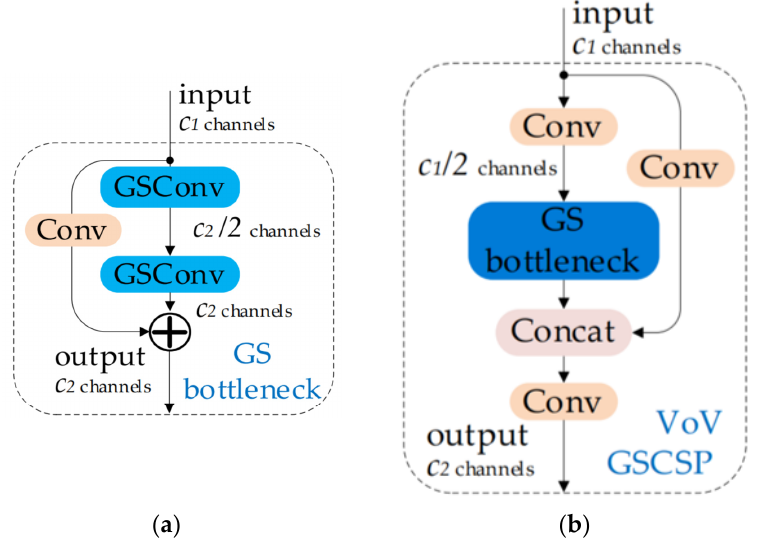
Figure 6. The structure of the GS bottleneck and VOV-GSCSP. ( a ) the structures of the GS bottleneck; ( b ) the structures of the VOV-GSCSP. Where GS bottleneck is the Ghost-Shuffle bottleneck; VOV- GSCSP is one-time aggregation cross stage partial network module.